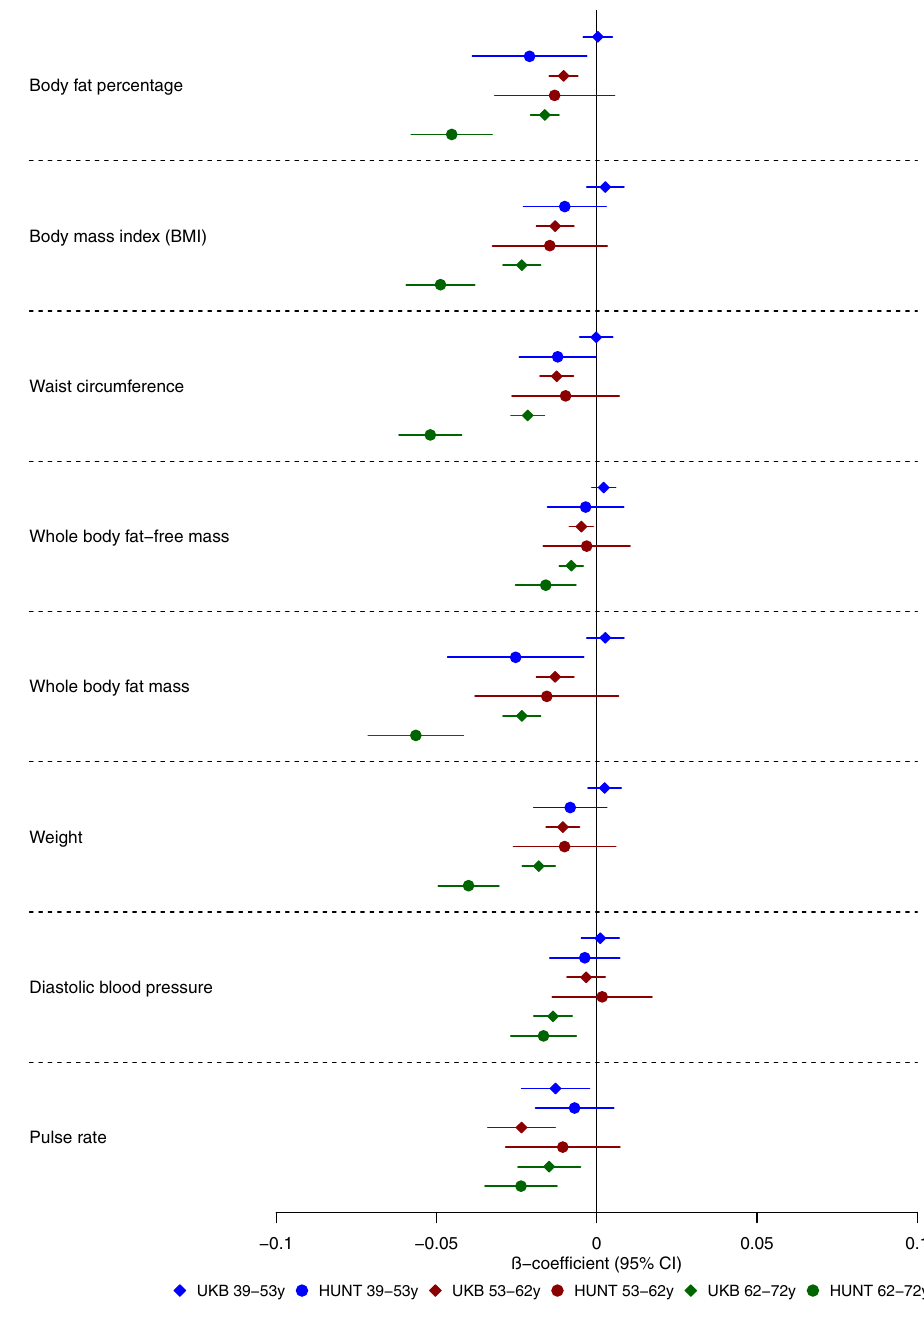
Fig. 5 | Forest plot showing the age-strati fi ed effect estimates for the associa- tion between the polygenic score for Alzheimer ’ s disease (including the APOE region) and physical measures in UK Biobank (diamond markers) and HUNT (replication sample, circle markers). Legends at the bottom of each graph